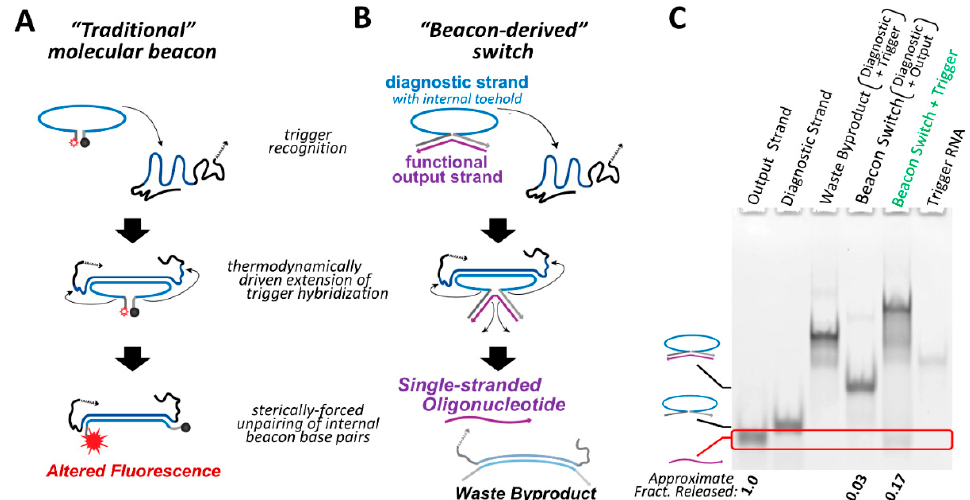
Figure 1. A conditional nucleic acid system based on the design of molecular beacons. ( A ) “Traditional” molecular beacons are fluorescence-based unimolecular diagnostic systems that adopt an initial hairpin structure. Hybridization of a trigger sequence complementary to the hairpin loop opens the hairpin and alters the fluorescence of the beacon by separating a fluorophore/quencher pair. ( B ) The “beacon-derived” switch is a biomolecular system composed of a diagnostic strand and an output strand. The output strand is hybridized to the 5 ′ and 3 ′ ends of the diagnostic strand